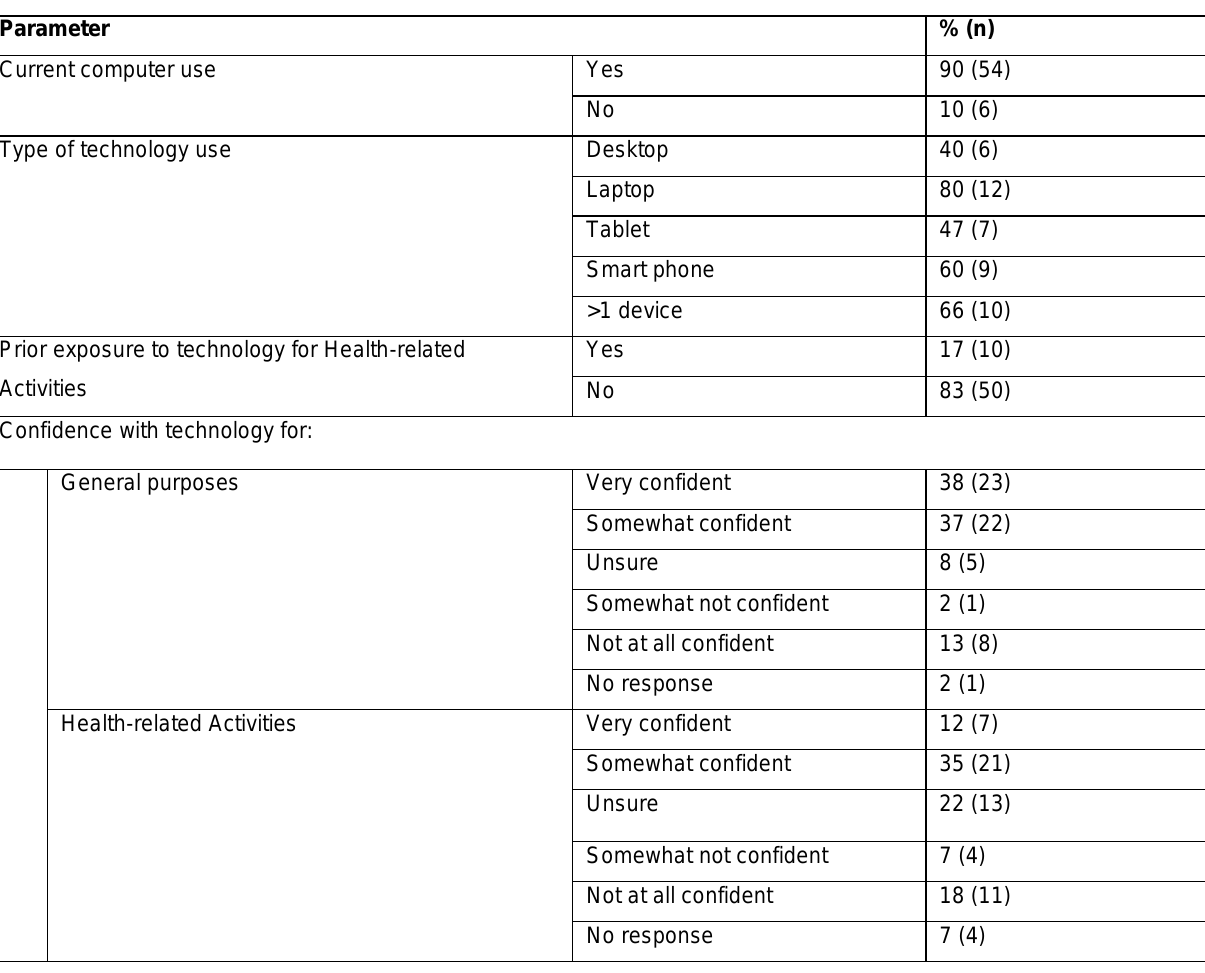
Table 2. Computer Literacy Questionnaire (n = 60)